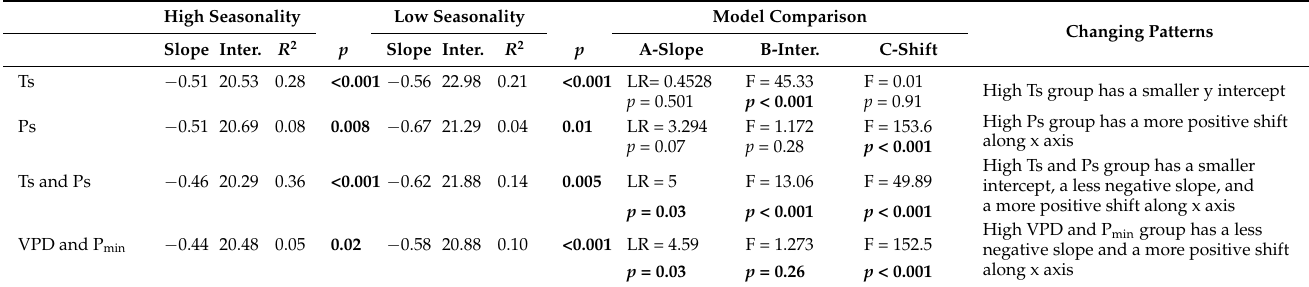
Table 2. Summary of SMA regression estimated the driving intensity and direction of foliar Δ 13C and δ 15N signals by climate seasonality.